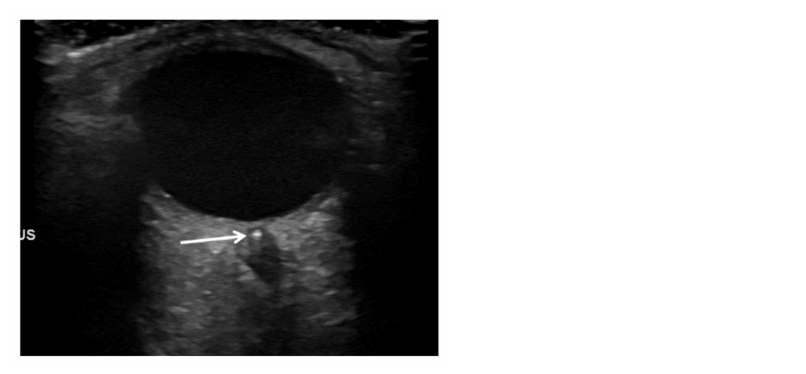
Figure 2. Ultrasound of orbital cavity with a retrobulbar spot sign (arrow) in central retinal artery. A p-MLM sign was visible on SD-OCT in 26 patients (63.4%) (Figure 3A), in 11 patients (26.8%) p-MLM could not be identified due to increased reflectivity of the entire inner retina (Figure 3B) (in four patients OCT was missing).